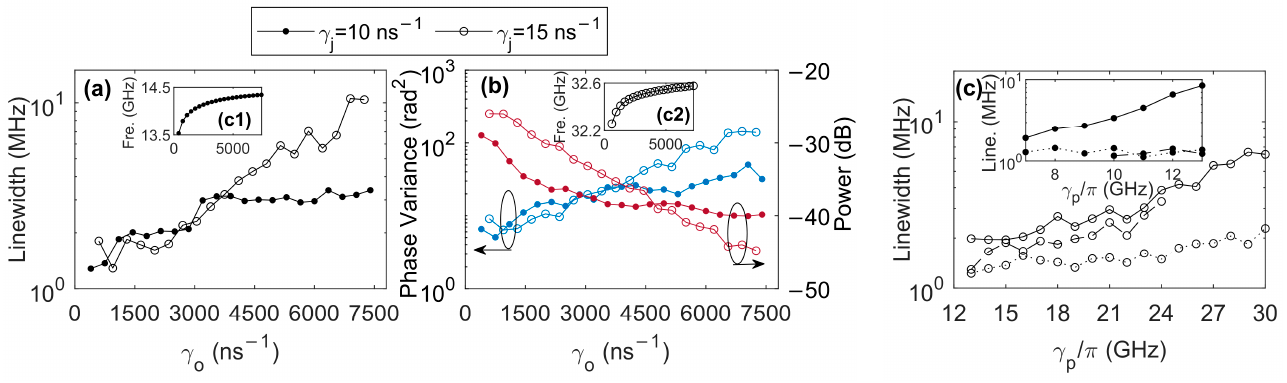
Figure 5. ( a ) Microwave linewidth, ( b ) phase noise variance (blue curve), power (crimson curve), and inset ( c1 , c2 ) microwave frequency of the solitary optically pumped QD spin-VCSEL versus the carrier capture rate, γ o . The solid dots indicate γ j = 10 ns − 1 and the birefringence, γ p = 10 π ns − 1 , and the empty circles represent γ j = 15 ns − 1 and γ p = 30 π ns − 1 . ( c ) Microwave linewidth at γ o = 400 ns − 1 (dashed line), γ o = 600 ns − 1 (dotted line) and γ o = 7000 ns − 1 (solid